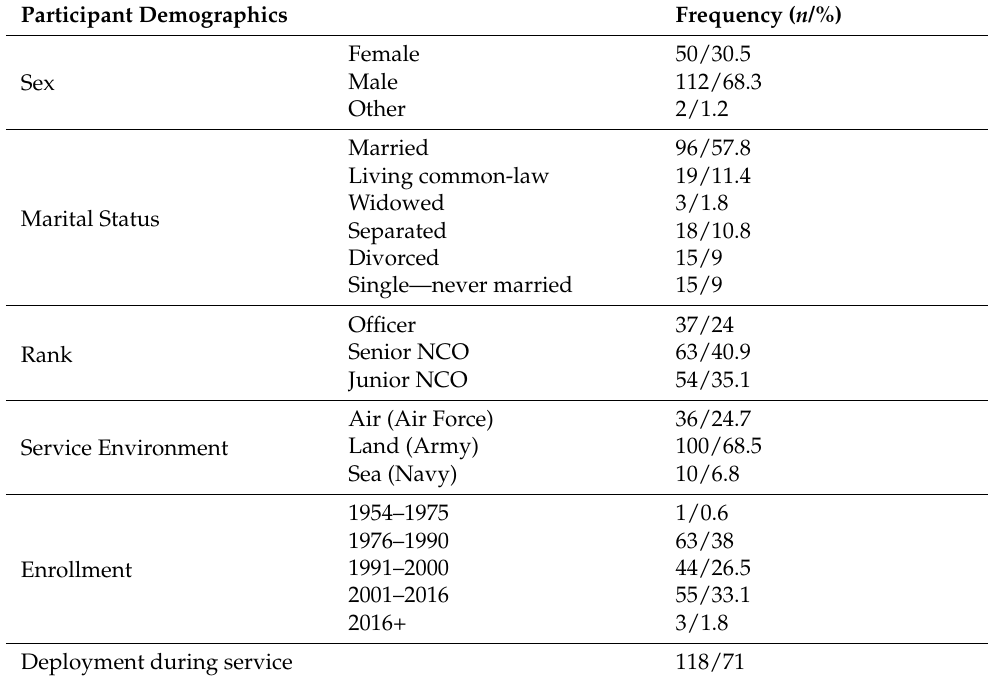
Table 1. Participant demographics ( N =